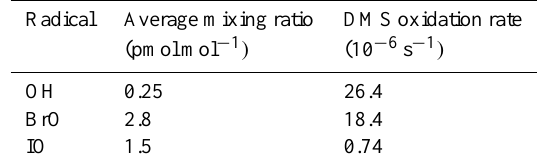
Table 1. Rates of DMS oxidation calculated for observations at Cape Verde. Rates of reactions: OH – Atkinson et al., 2004; IO – Dillon et al., 2006; BrO – Sander et al.,